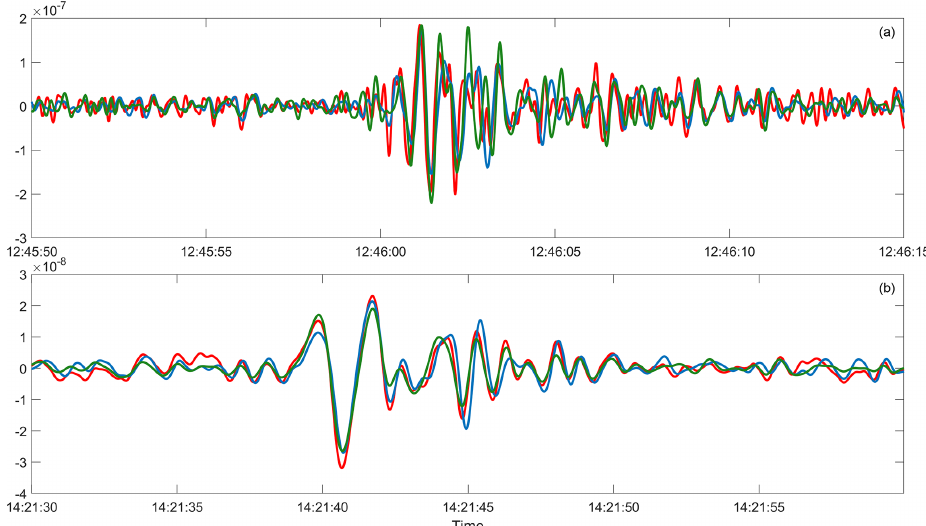
Figure 6. Array-derived strain estimates at station Bb04 (Fig. 1) using the SIM (green line) and the SGM (blue line) in comparison with DAS strain data (red line). Computations are performed for the VE (a) and LP (b)